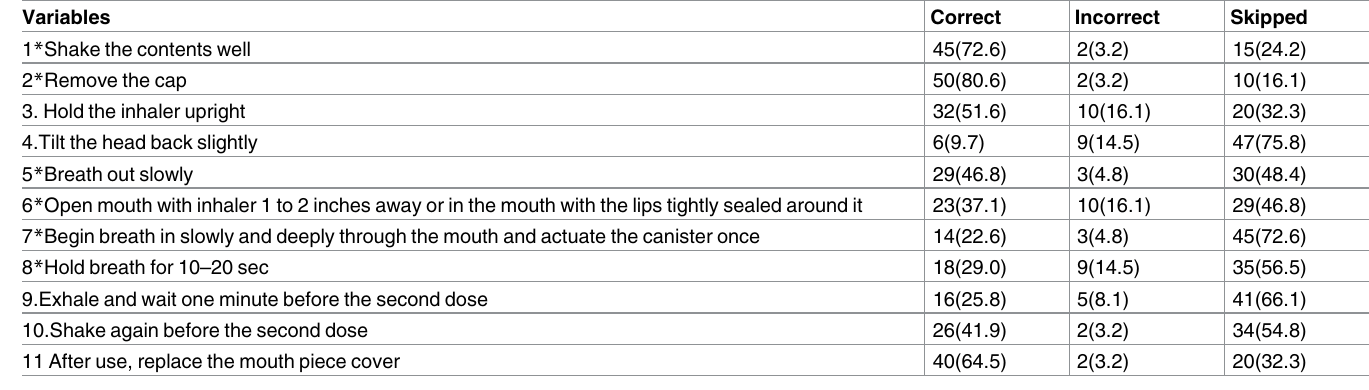
Table 1. Frequency of evaluation of respondents to demonstrate each step of metereddose inhaler technique, 2017.